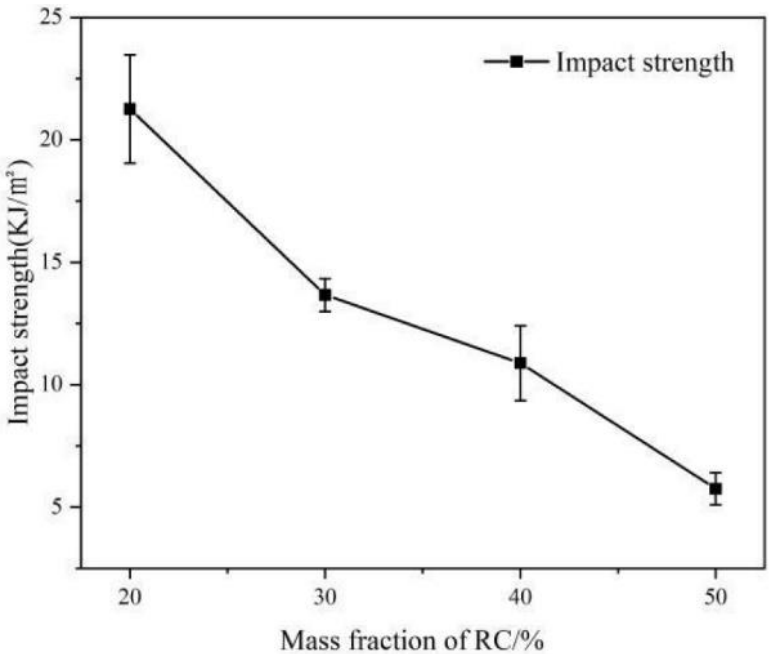
Figure 2. Impact properties of RC/PP Composites.